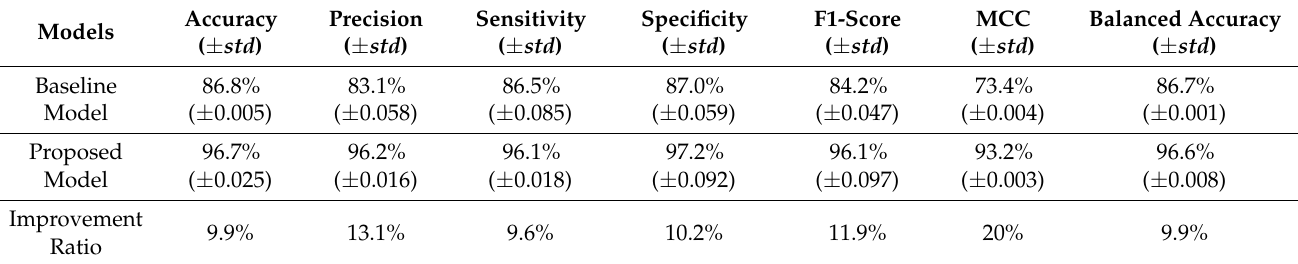
Table 7. Performance of the baseline and proposed models.